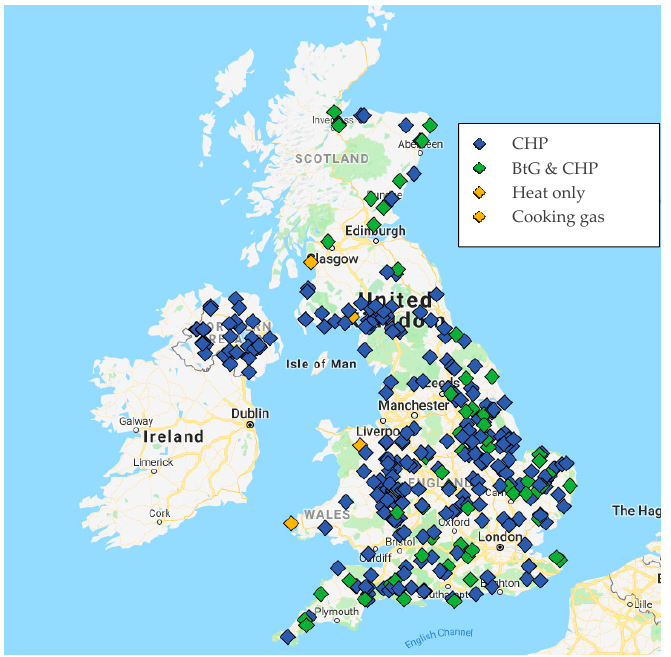
Figure 2. UK map showing the location of anaerobic digestion plants including their end-use. CHP (combined heat and power), BtG (biomethane to grid). Reproduced with permission from [82]. Copyright NNFCC, 2019.